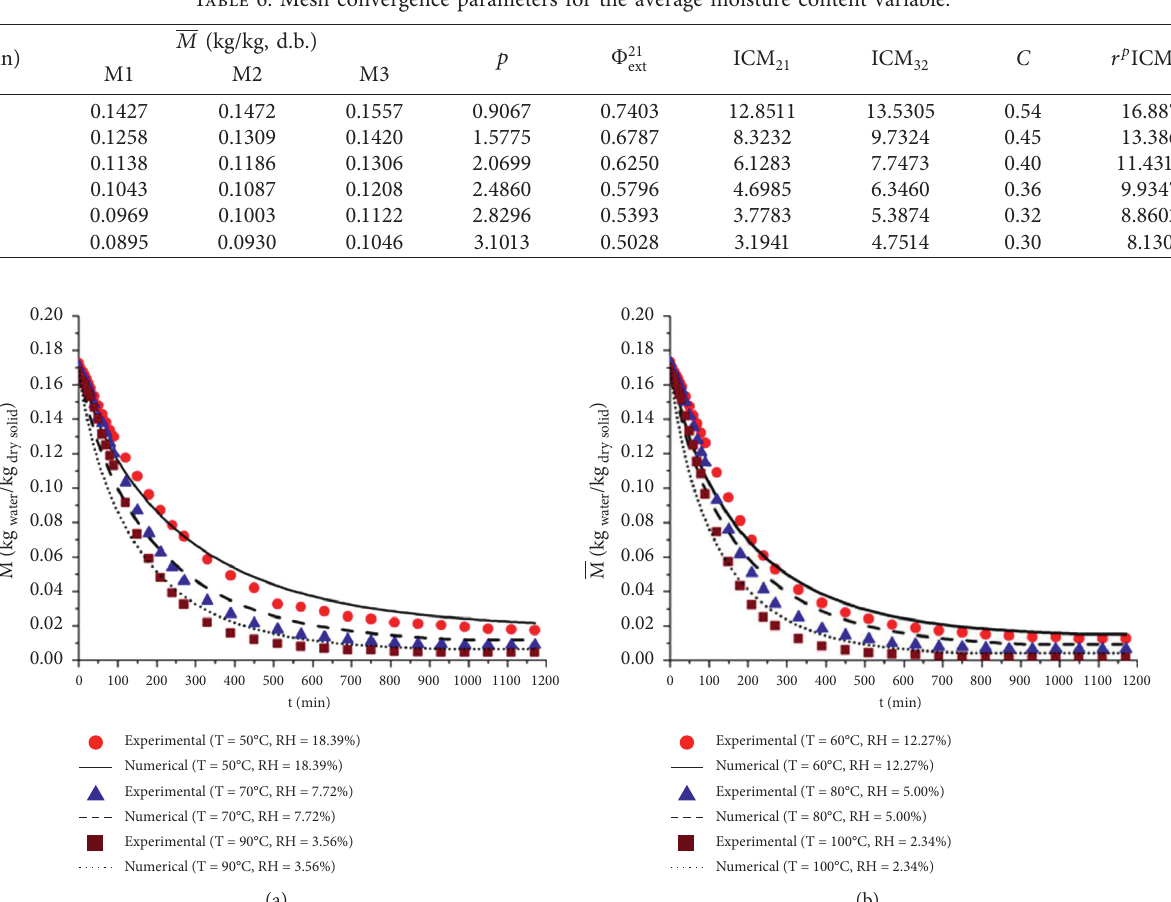
Figure 6: Analysis lines along the brick used in the mesh refining study. Table 6: Mesh convergence parameters for the average moisture content variable.